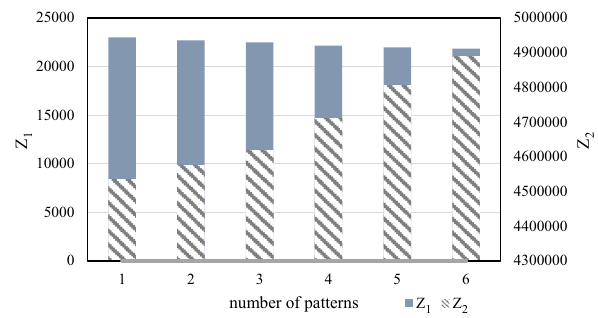
Fig. 8 The values of objective functions as against the different number of